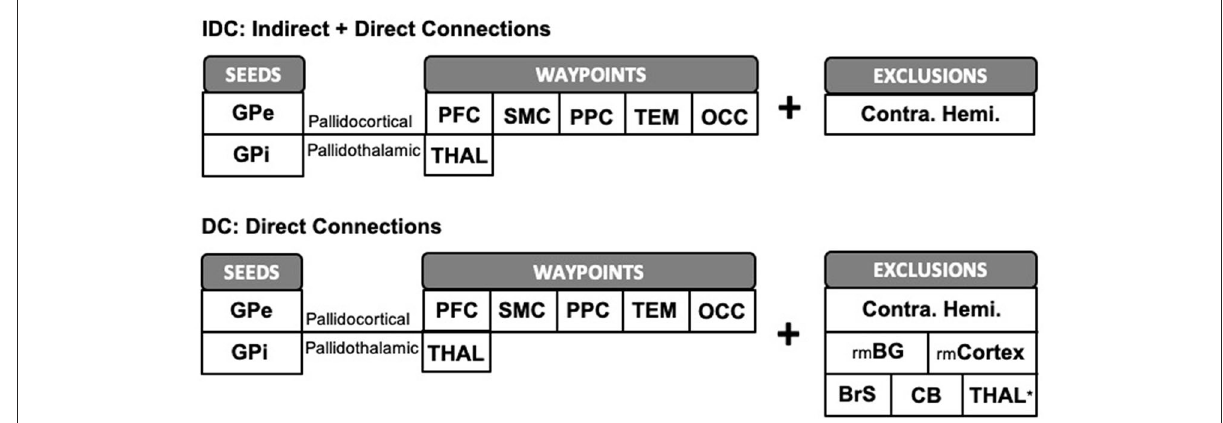
FIGURE2 Schematic representation of pallidocortical and pallidothalamic tractography workflow. We ran probabilistic tractography twice, both times limiting the tractography ipsilaterally by supplying an exclusion mask of the contralateral hemisphere. The first procedure, IDC, was carried out with GPe/GPi each serving as a seed ROI with cortical or thalamic ROIs as waypoints, without being restricted by additional exclusion criteria. To limit the influence of indirect connections, we repeated tractography with additional exclusion criteria to better reflect direct pallidal connections (DCs). GPe, external globus pallidus; GPi, internal globus pallidus; PFC, prefrontal; SMC, sensorimotor; PPC, posterior parietal; TEM, temporal; OCC, occipital; THAL, thalamus; rmBG, remaining basal ganglia regions; rmCortex, remaining cortical regions; BrS, brainstem; CB, cerebellum; Contra. Hemi., contralateral hemisphere. *N/A for pallidothalamic tractography.